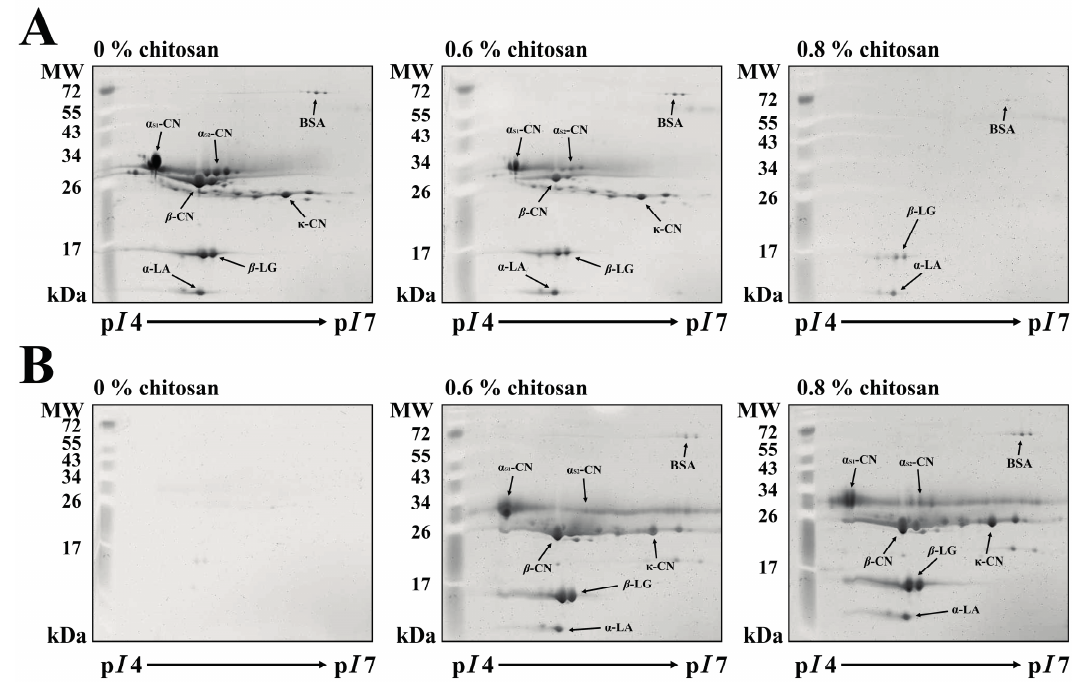
Figure 4. Changes in the two-dimensional polyacrylamide gel electrophoresis profiles of milk proteins following treatment with different concentrations of chitosan (0%, 0.6%, or 0.8%) at 30 °C for 1 h. ( A ) milk supernatant fraction; ( B ) milk pellet fraction; M: protein marker; MW: molecular weight; p I : isoelectric